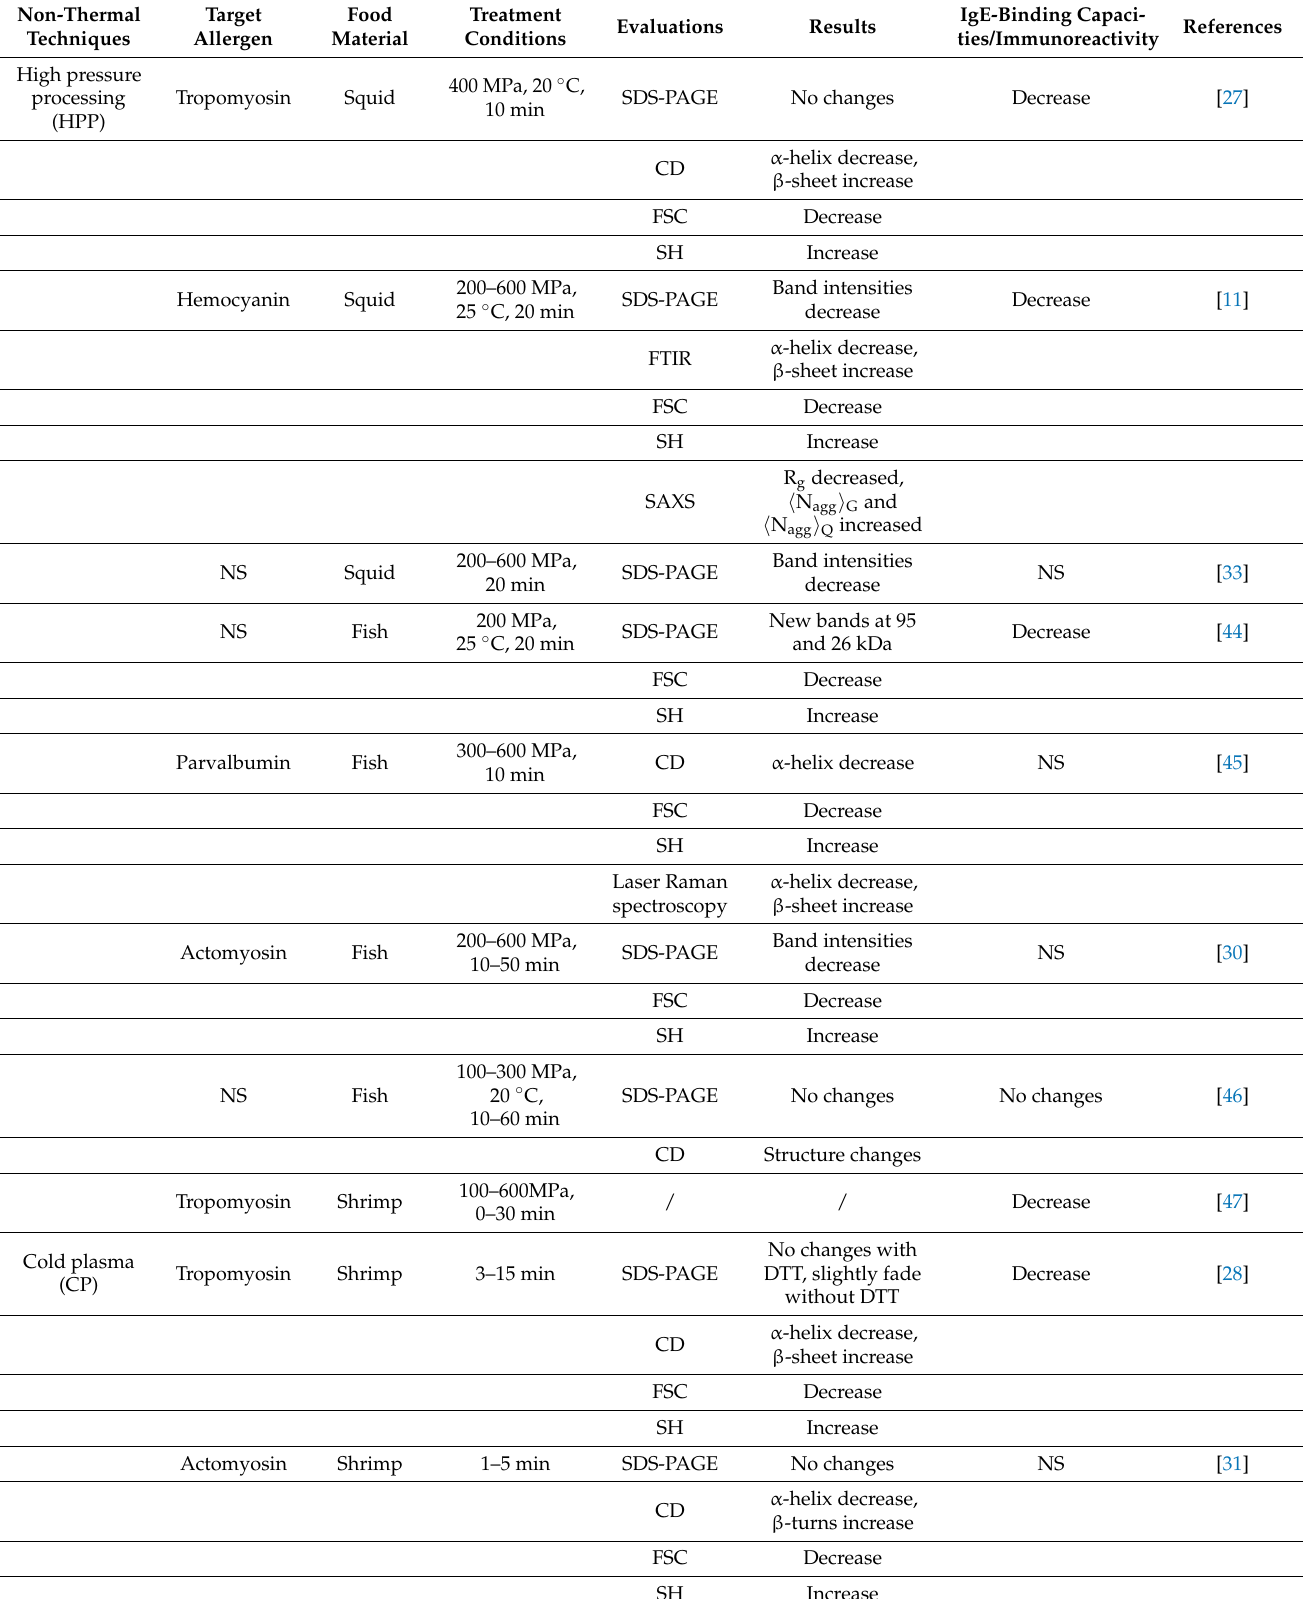
Table 1. An overview of studies evaluating the effects of non-thermal processing on the structure of seafood